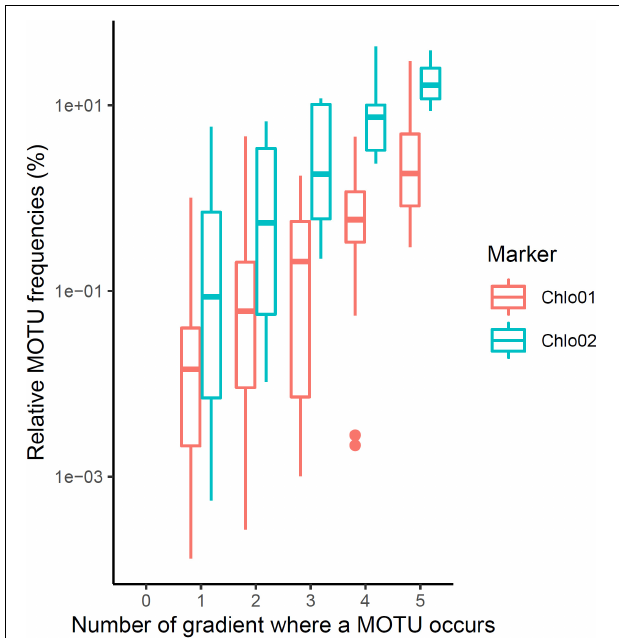
FIGURE 4 | Endemism of the MOTUs according to their maximum frequency of occurrence in one of the gradients. The higher a MOTU has a high frequency of reads on at least one gradient, the more likely it will be present in many